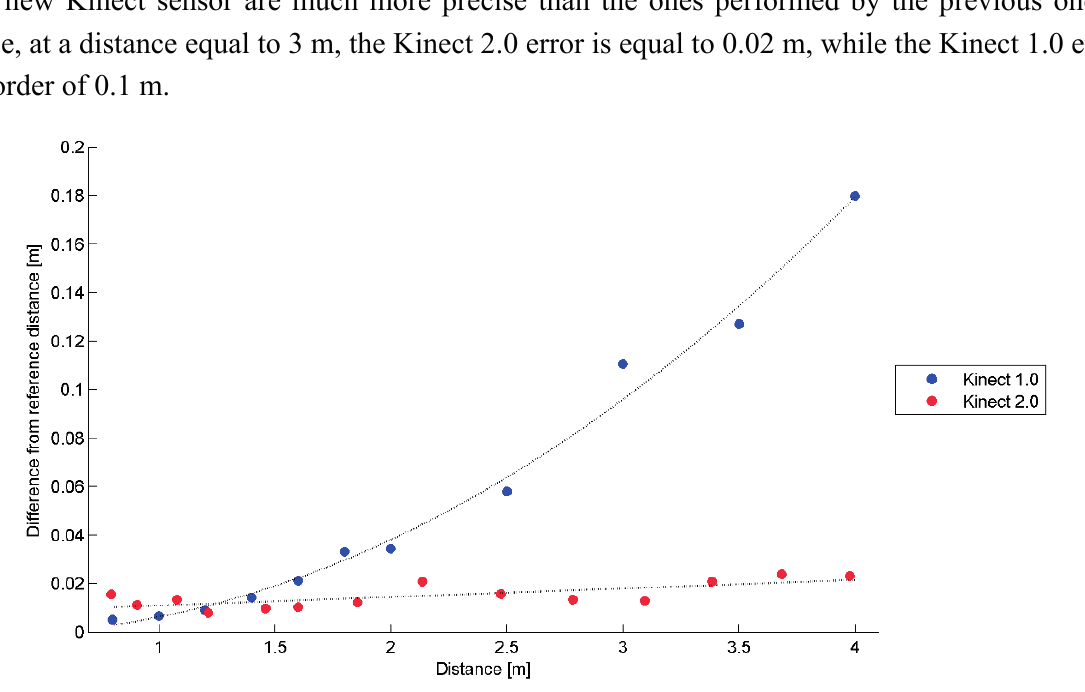
Figure 9. Estimation of the error committed by the two Kinect sensors as a function of the distance between the device and the